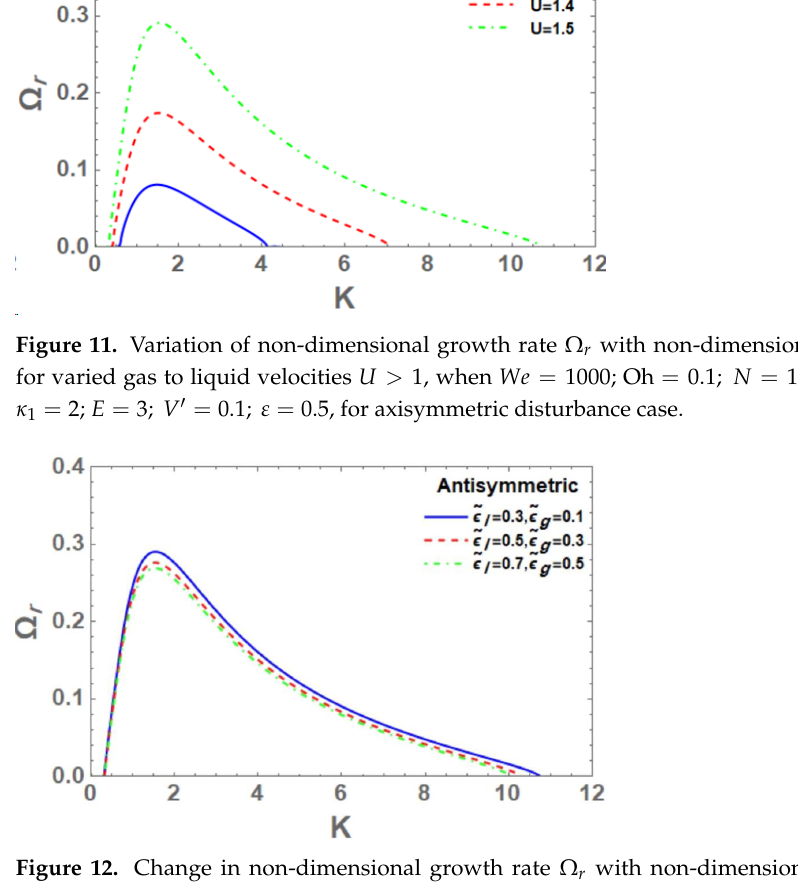
Figure 12. Change in non-dimensional growth rate Ω r with non-dimensional wave number K for various dielectric constants values ˜ (cid:101) l and ˜ (cid:101) g , when We = 1000; Oh = 0.1; N = 1; ρ = 0.01;